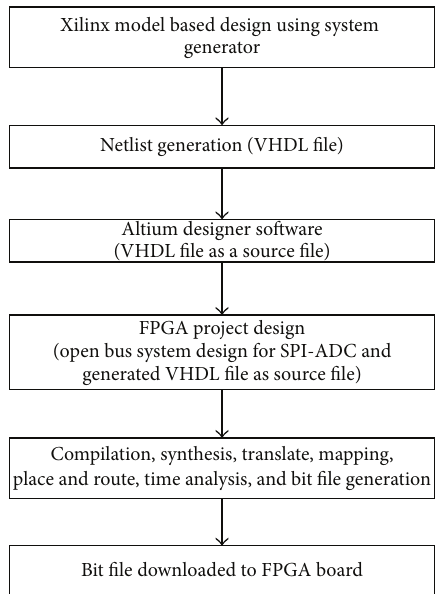
Figure22:Step-by-stepprocedureforinvertergatepulsegeneration using FPGA.